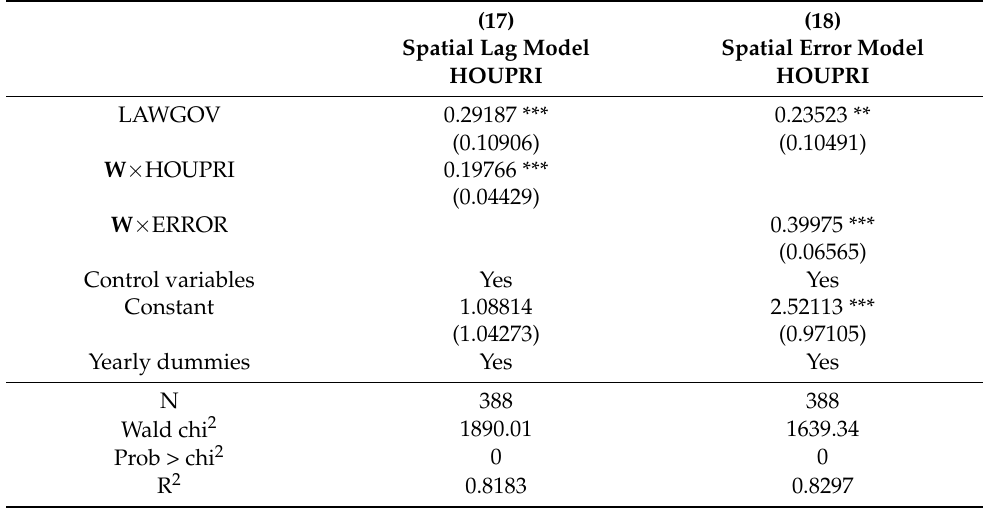
Table 10. Maximum likelihood (ML) estimation of spatial